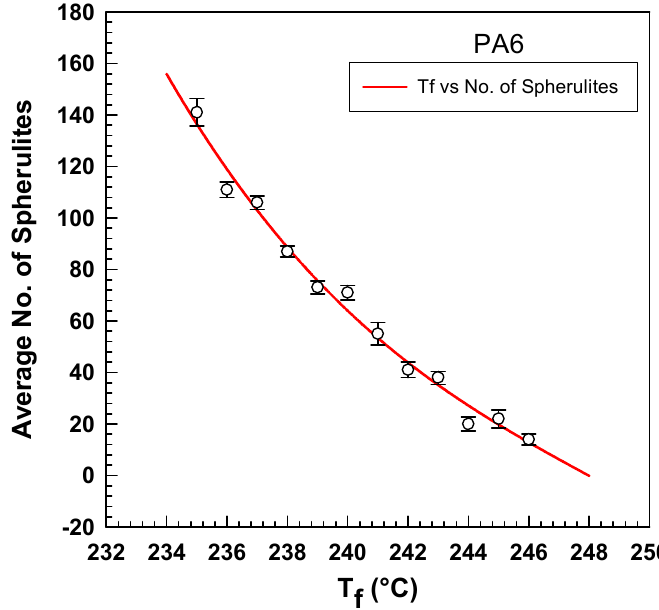
Figure 10. Effect of the fusion temperature on the number of spherulites of PA6 Figure 10. E ff ect of the fusion temperature on the number of spherulites of PA6 crystallization.